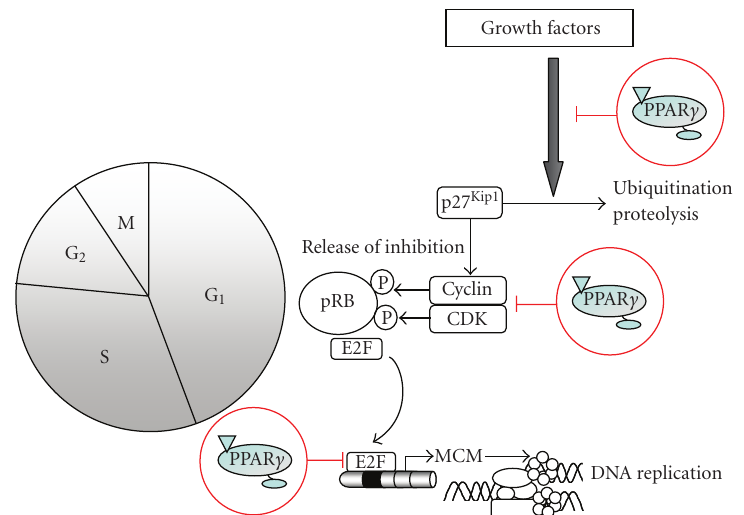
Figure 2: PPAR γ targets cell-cycle progression. Phosphorylation of the retinoblastoma gene product (pRB) by specific G 1 CDKs represents the critical checkpoint of the G 1 /S transition of the cell cycle. pRB phosphorylation releases E2F allowing the expression of genes required for DNA synthesis. By preventing the degradation of the CDK inhibitor (CDKI) p27 Kip1 , PPAR γ ligands inhibit mitogen-induced pRB phosphorylation and downstream expression of key E2F-regulated genes (i.e., MCM genes) responsible for the initiation of DNA